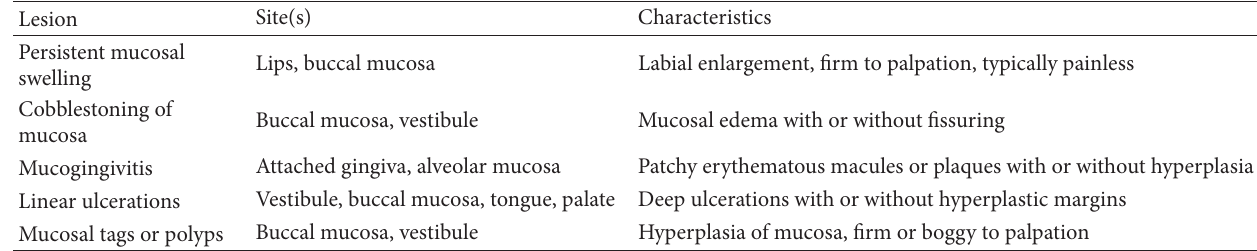
Table 1: Oral manifestations of Crohn’s